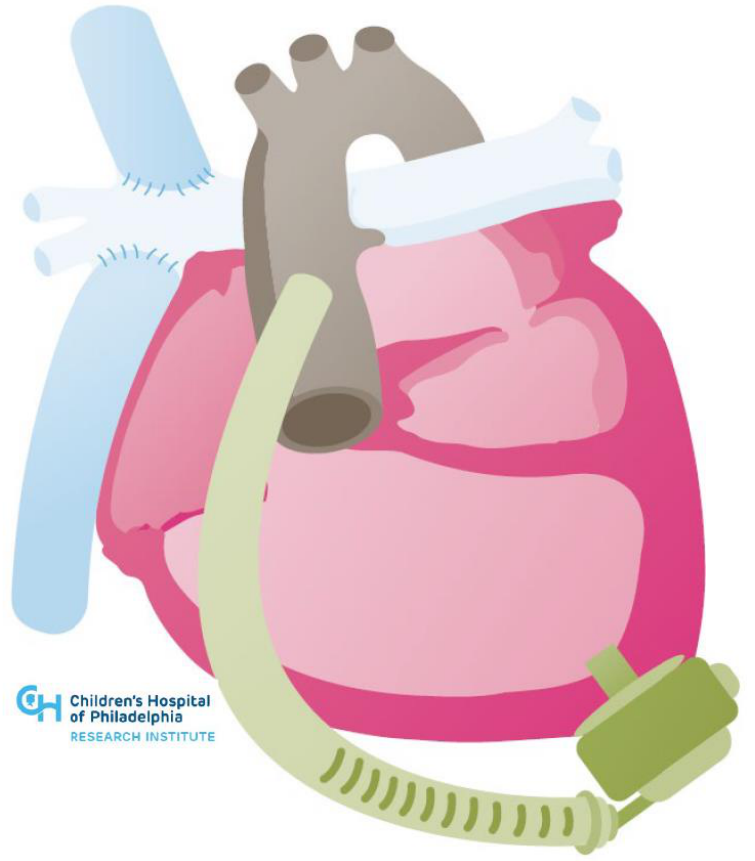
Figure 2. Illustration of HeartMate 3 placement in hypoplastic left heart syndrome post-Fontan.